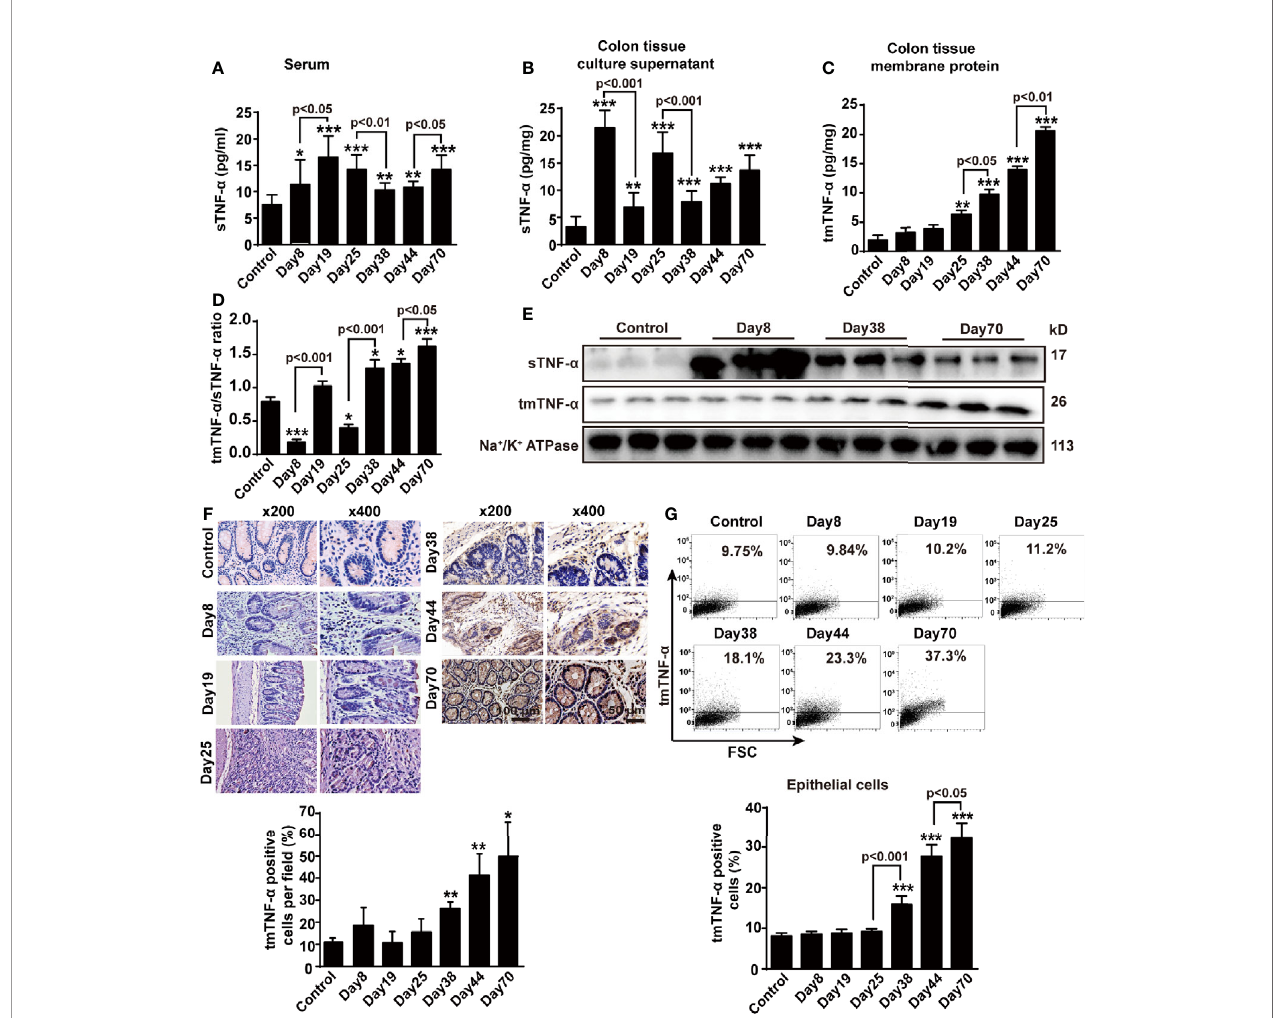
FIGURE 2 | sTNF- a levels are increased at the in fl ammation stage, but tmTNF- a expression is enhanced at the tumor stage. Mice were treated with AOM and DSS as described in Figure 1A (n = 6, each group). (A) Serum concentrations of sTNF- a detected by ELISA. Levels of sTNF- a released in supernatants (B) and tmTNF- a expression in the membrane protein (C) of 24-h-cultured colonic tissues detected by ELISA and their ratios (D) . (E) Western blot analysis of sTNF- a in colonic homogenates and tmTNF- a in colonic membrane protein. (F) Representative immunohistochemical staining for intracolonic expression of tmTNF- a (x200, ×400) and their quantitative data. (G) Representative cytogram for tmTNF- a expression on colonic epithelial cells isolated from AOM/DSS-treated mice analyzed by fl ow cytometry and their quantitative data. All quantitative data are expressed as means ± SEM, *P < 0.05, **P < 0.01, ***P < 0.001 versus